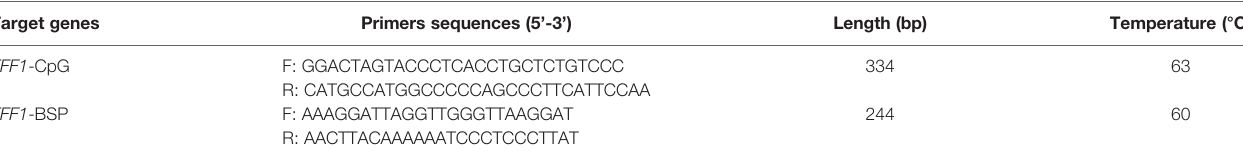
TABLE 5 | The primers of CpG island and BSP-PCR primers in TFF1